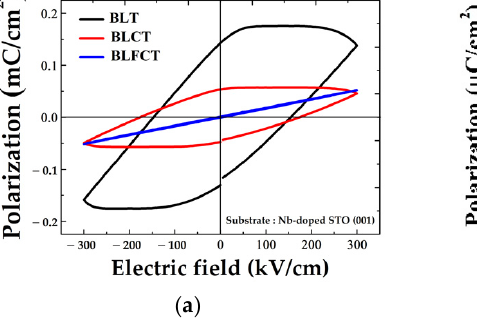
Figure 4. ( a ) Polarization -electric field loops were observed using the ferroelectric tester for the BLT, BLCT, and BLFCT films on the Nb-SrTiO 3 (001) substrate (Room temperature, frequency of 10 kHz) . ( b , c ) P-E hysteresis loops for the two films; BLT and BLCT films were tested with the frequency range of 0.8–20